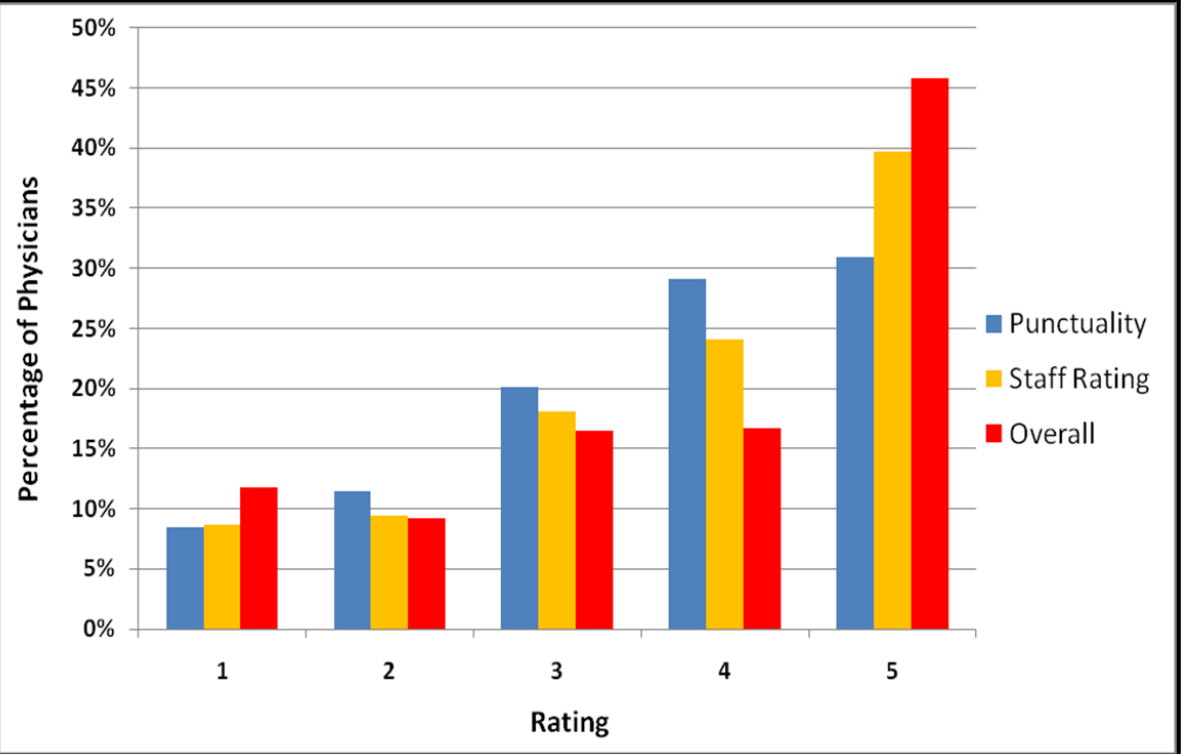
Figure 3. Distribution of quality ratings across